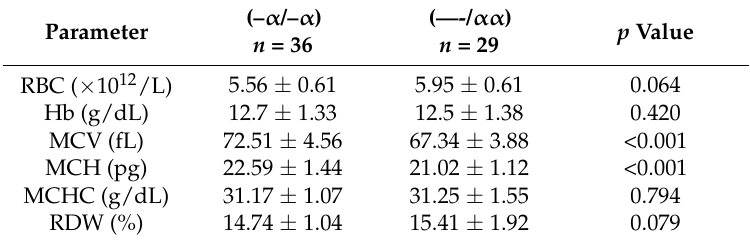
Table 4. Comparison of hematologic parameters of homozygous α + thalassemia (– α /– α ) and heterozygous α 0 thalassemia (—-/ αα ). Data represent mean ± SD (standard deviation). p values less than 0.05 were considered statistically